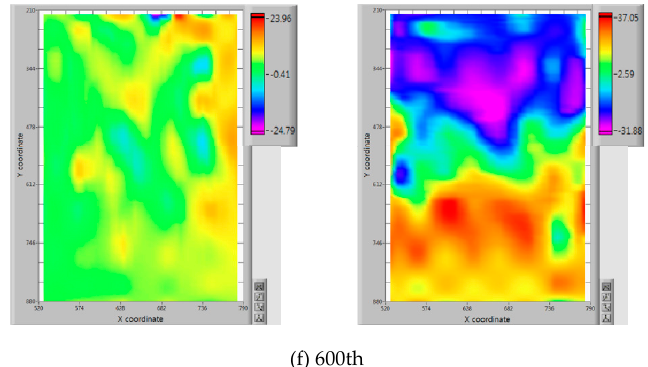
Figure 8. The results of displacements distribution by the conventional DIC algorithm. (Left: x-direction, Right: y-direction deformation result.)